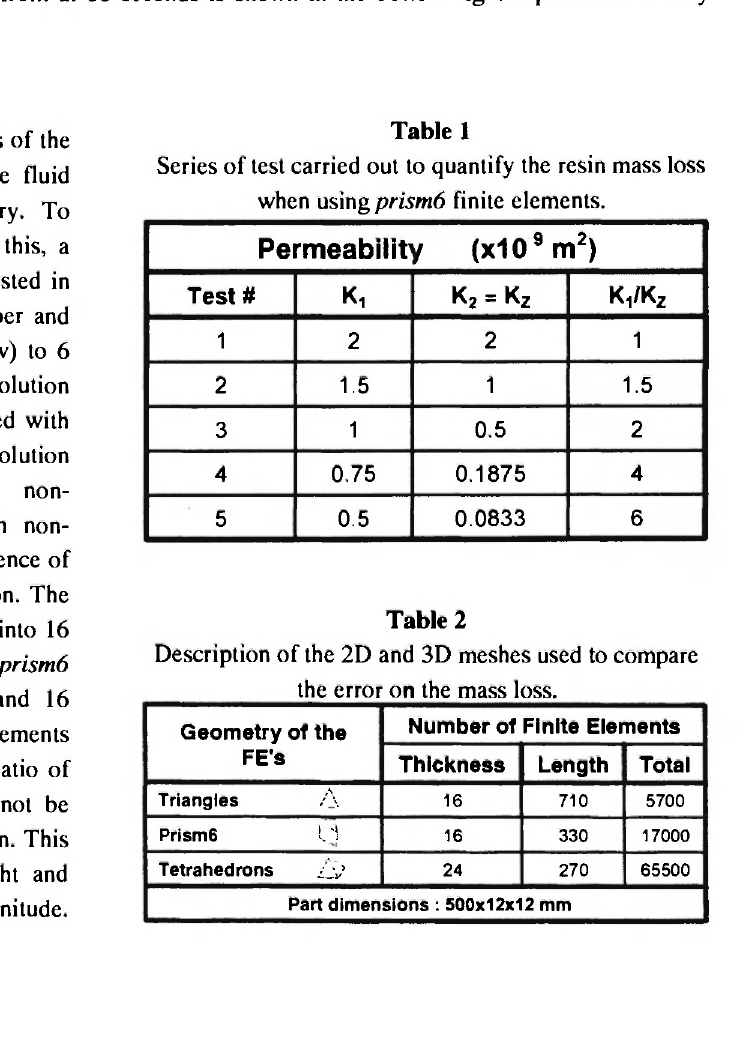
Series of test carried out to quantify the resin mass loss when using prism6 finite elements.